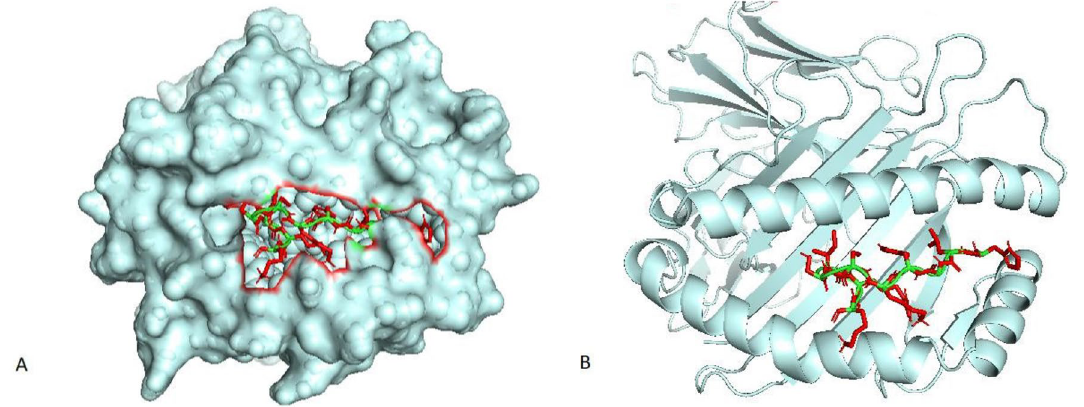
Figure 1. Visualization of the docking between the epitope HLGYKCSIRK and its corresponding MHC allele (HLA-A*03:01) using the PyMol software: ( A ) Surface View. ( B ) Cartoon View.